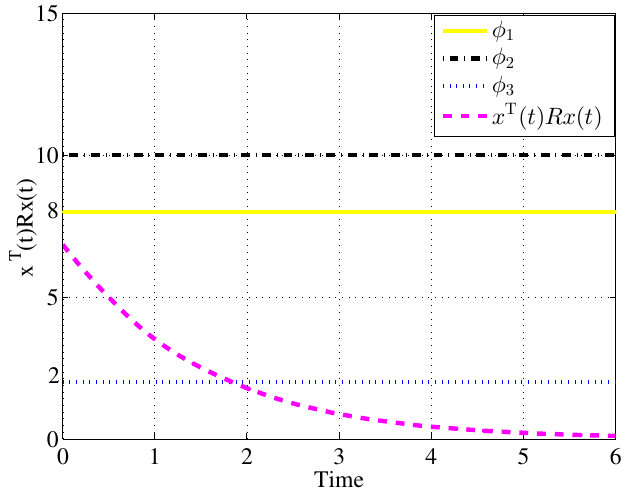
Figure 7. Illustration of system state x ( t ) .